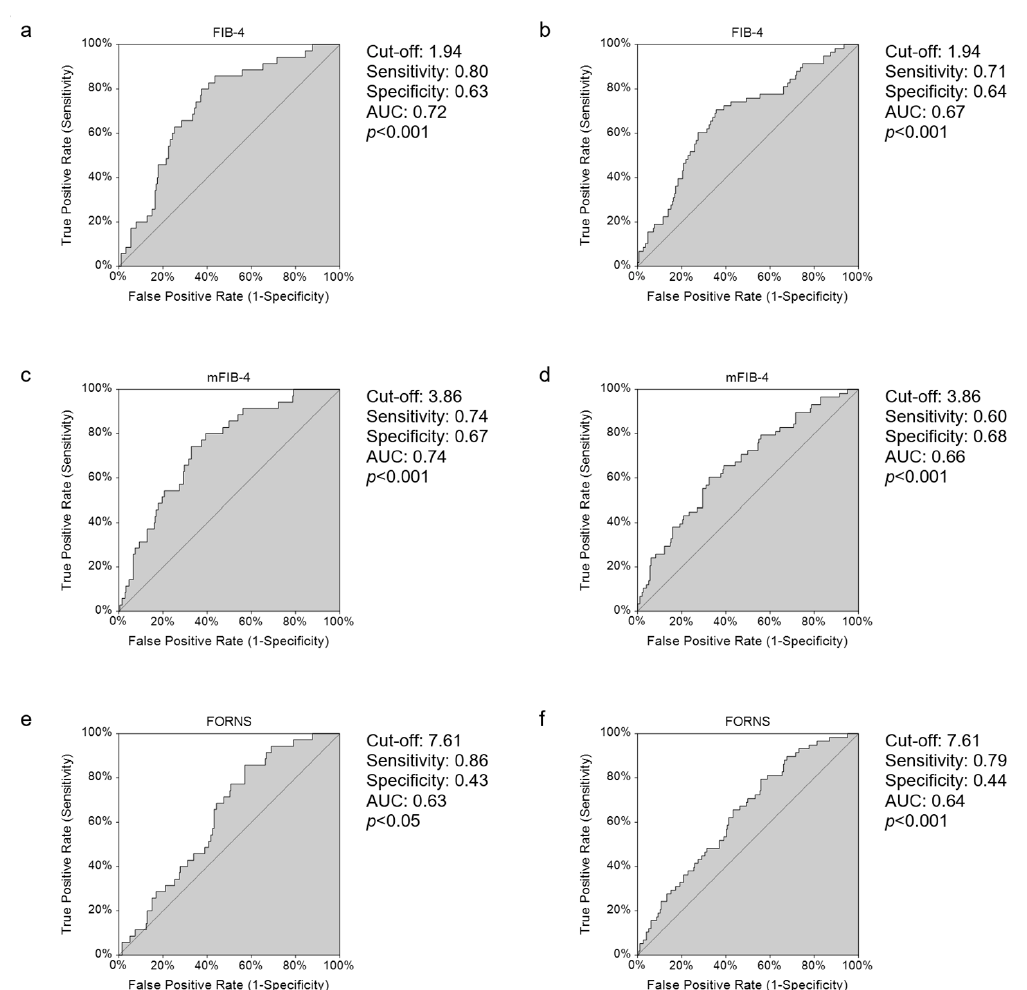
Figure 5. ROC curves for mortality and severity of disease of FIB-4 ( a , b ), mFIB-4 ( c , d ), and FORNS ( e , f ). The graphs indicate cut off values with respective sensitivity and specificity levels and empirical estimation of area under curve (AUC) with upper 1-sided p -value ( p ). Abbreviations: fibrosis-4 index, FIB-4; modified FIB-4, mFIB-4.